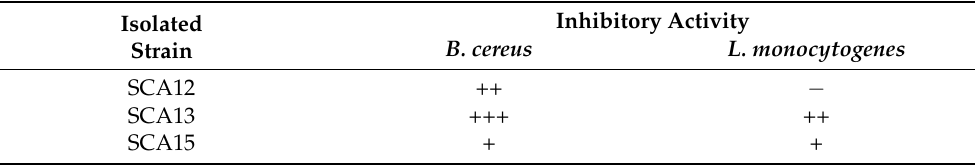
Table 3. Well-Diffusion test results of lyophilized isolated extracts. ( − ) No activity, (+) Low activity (<11 mm), (++) Medium activity (12 – 14 mm) and (+++) High (>15 mm) activity. Isolated